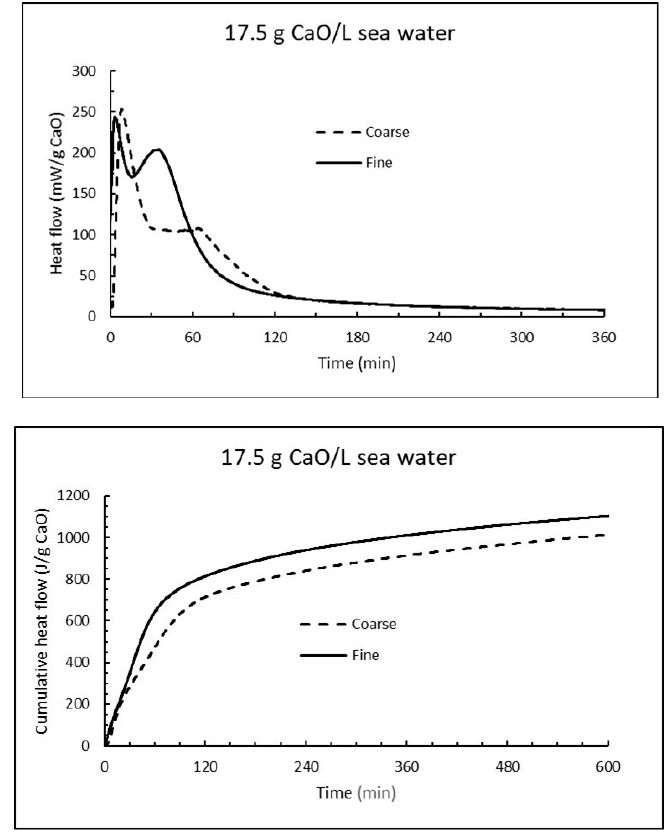
Figure 15. The heat flow ( top ) and cumulative heat ( bottom ) under isothermal conditions at 15 °C when 17.5 g CaO is mixed with 1 litre sea water.